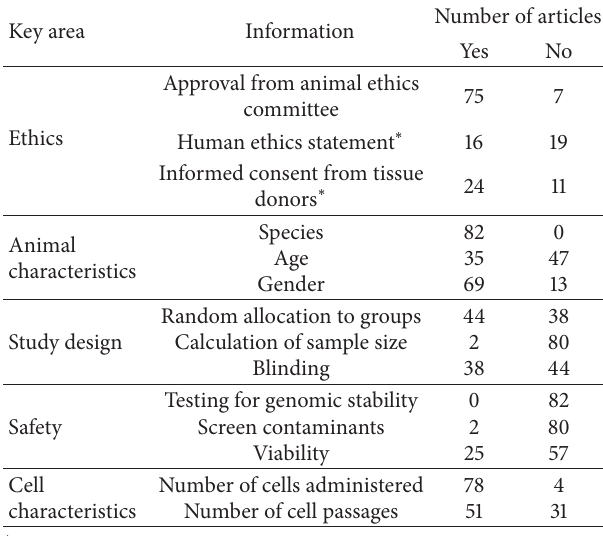
Table 6: Summary of reporting on selected key areas and parame- ters in papers that reported the use of ASC in animals ( 𝑛 = 82